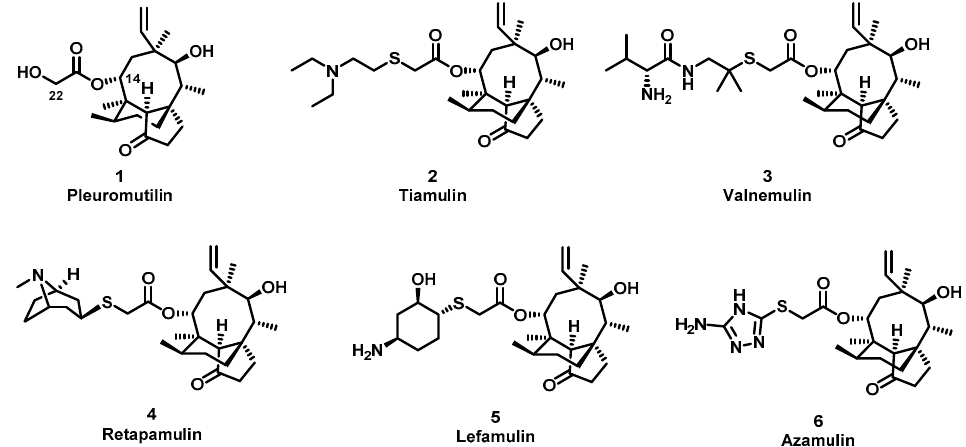
Figure 1. Structure of pleuromutilin ( 1 ), tiamulin ( 2 ), valnemulin ( 3 ), retapamulin ( 4 ), lefamulin ( 5 ) and azamulin ( 6 ).